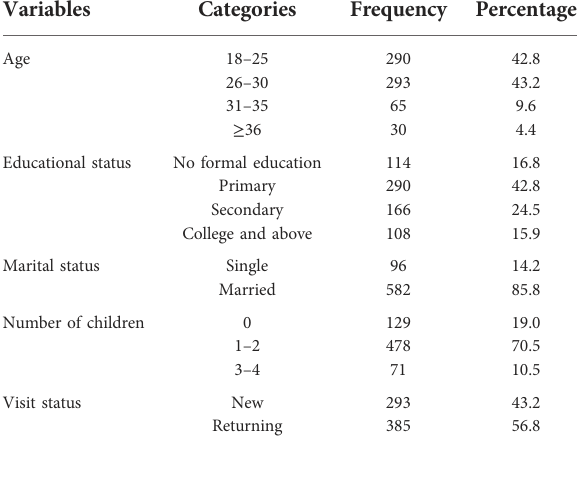
TABLE 1 Sociodemographic characteristics of women attending family planning clinics at health centers in Akaki Kality sub-city, Addis Ababa, Ethiopia, 2020 ( N =678).